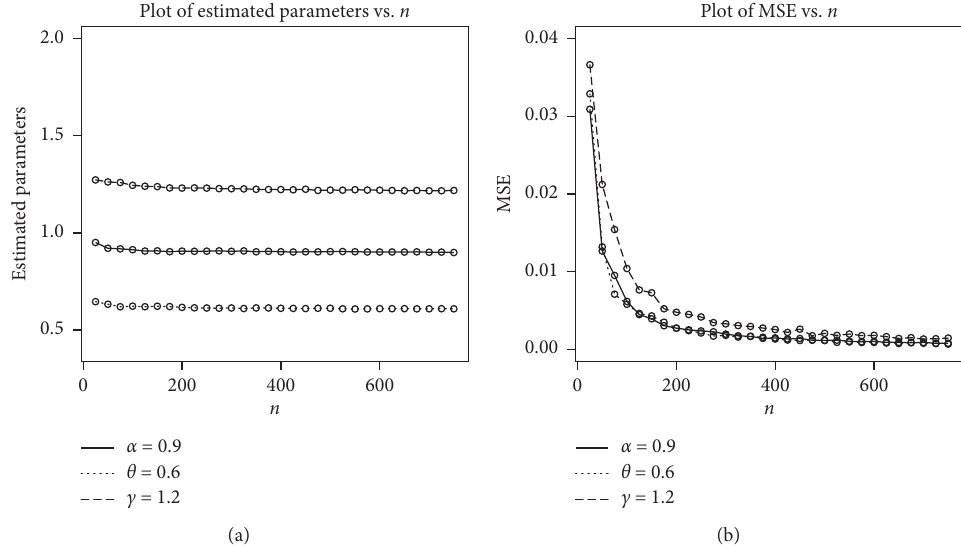
Figure 9: MLEs and MSEs plots of the NGE-Weibull distribution for α � 0 . 9, θ � 0 . 6, and c � 1 . 2.